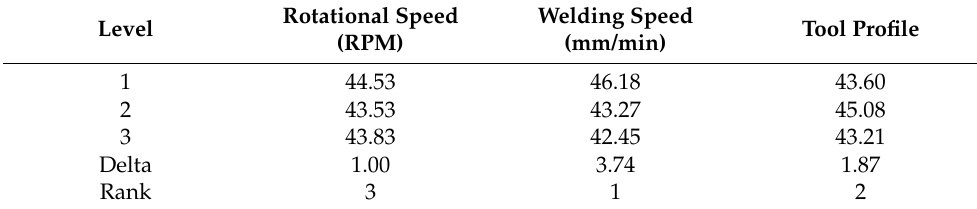
Table 4. Response table means for the S/N ratio for tensile